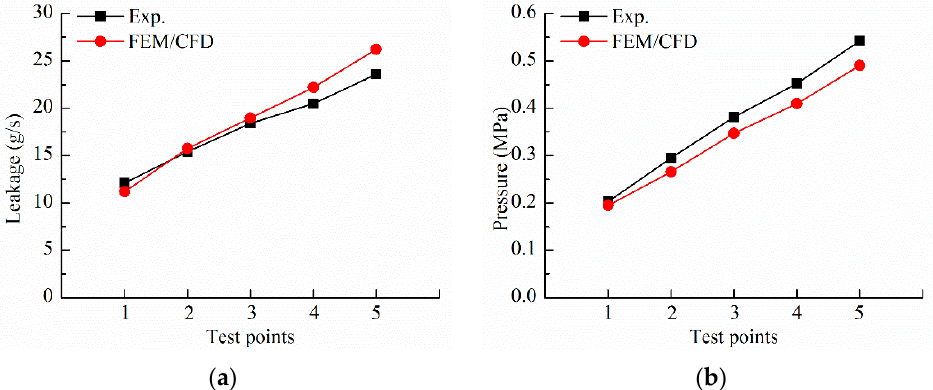
Figure 11. Comparison between the numerical results and the experimental results: ( a ) Leakage, ( b ) pressure in middle ‐ pressure cavity.